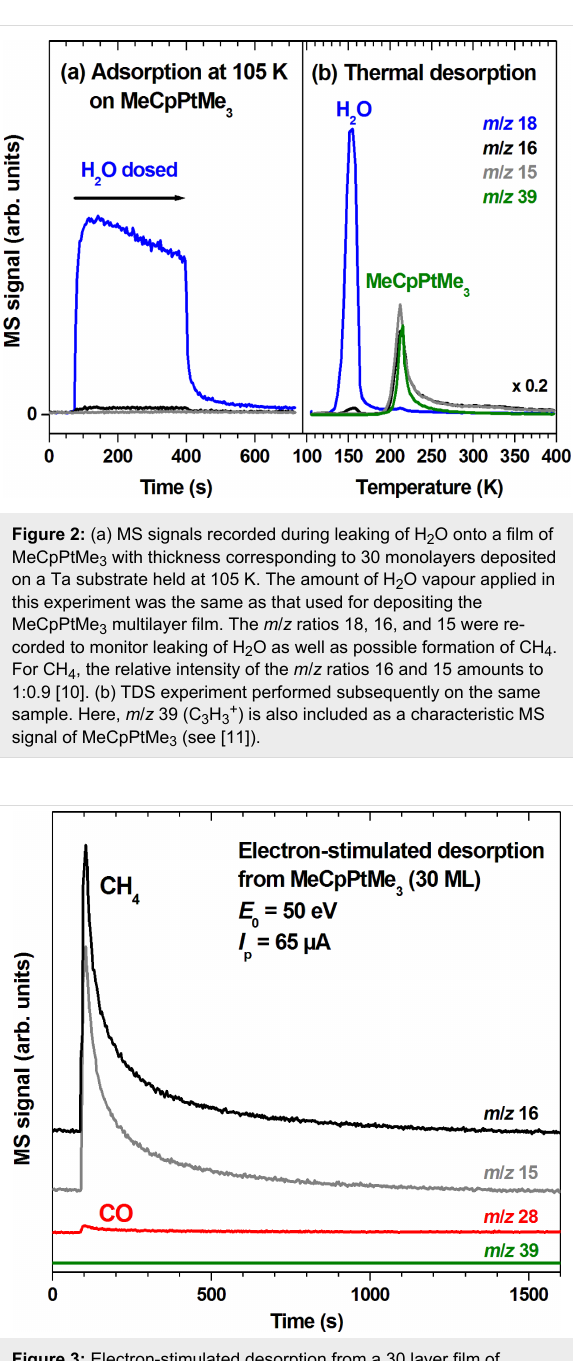
Figure 3: Electron-stimulated desorption from a 30 layer film of MeCpPtMe 3 on a Ta substrate held at 105 K. An incident electron cur- rent I p of 13 μ A/cm 2 was applied at E 0 = 50 eV. The m / z ratios 16 and 15 were recorded to monitor formation of CH 4 for which the relative in- tensity of the m / z ratios 16 and 15 amounts to 1:0.9 [10]. The m / z ratio 28 indicates desorption of CO and of traces of ethane (see Supporting Information File 1, Figure S2), while m / z 39 (C 3 H 3+ ) is also included as a characteristic MS signal of MeCpPtMe 3 (see